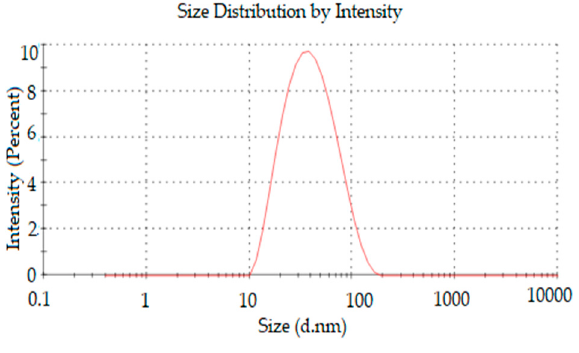
Figure 4. Representative TEM images of the optimized Ucuùba fat NLC formulations ( a ) F 30 and ( b ) F 85 (magnification 100,000 × ).